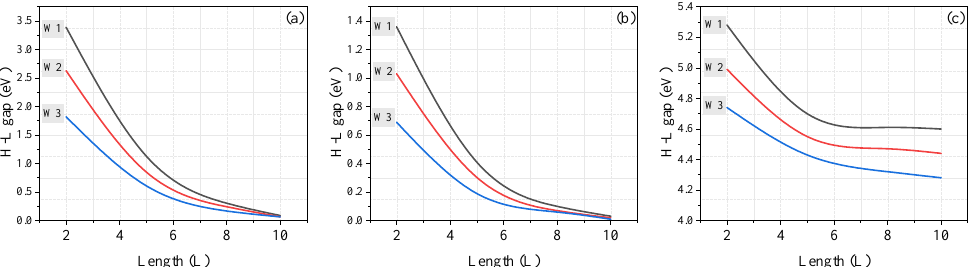
Figure 5. HOMO–LUMO band-gap behavior as a function of the length and width for ( a ) graphene, ( b ) silicene, and ( c ) h-BN finite-length zigzag